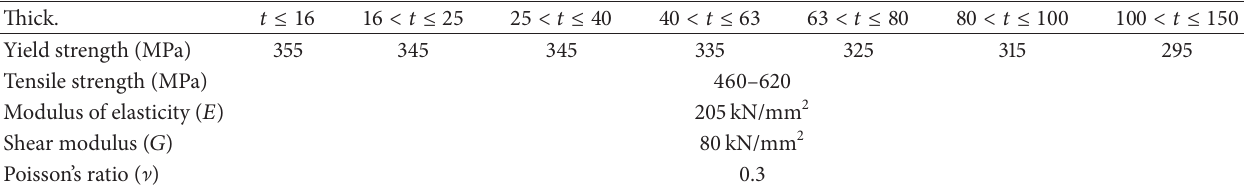
Table 2: Material properties of S355